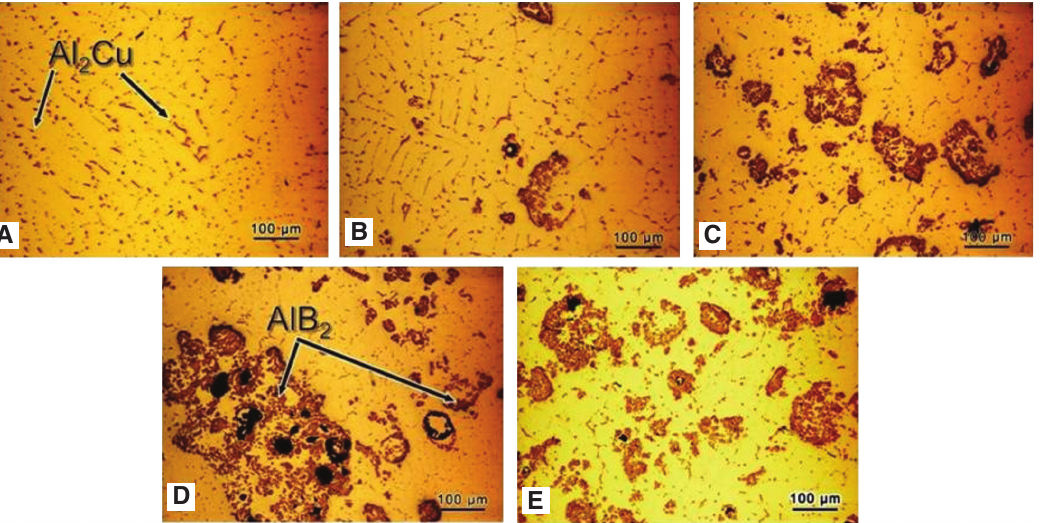
distribution as boron levels increase from 0 to 4 wt%: (A) Al-2.5 wt% Cu-1 wt% Mg-0 wt% Figure 1 Optical micrographs showing the AlB 2 B, (B) Al-2.5 wt% Cu-1 wt% Mg-1 wt% B, (C) Al-2.5 wt% Cu-1 wt% Mg-2 wt% B, (D) Al-2.5 wt% Cu-1 wt% Mg-3 wt% B, (E) Al-2.5 wt% Cu-1 wt% Mg-4 wt%